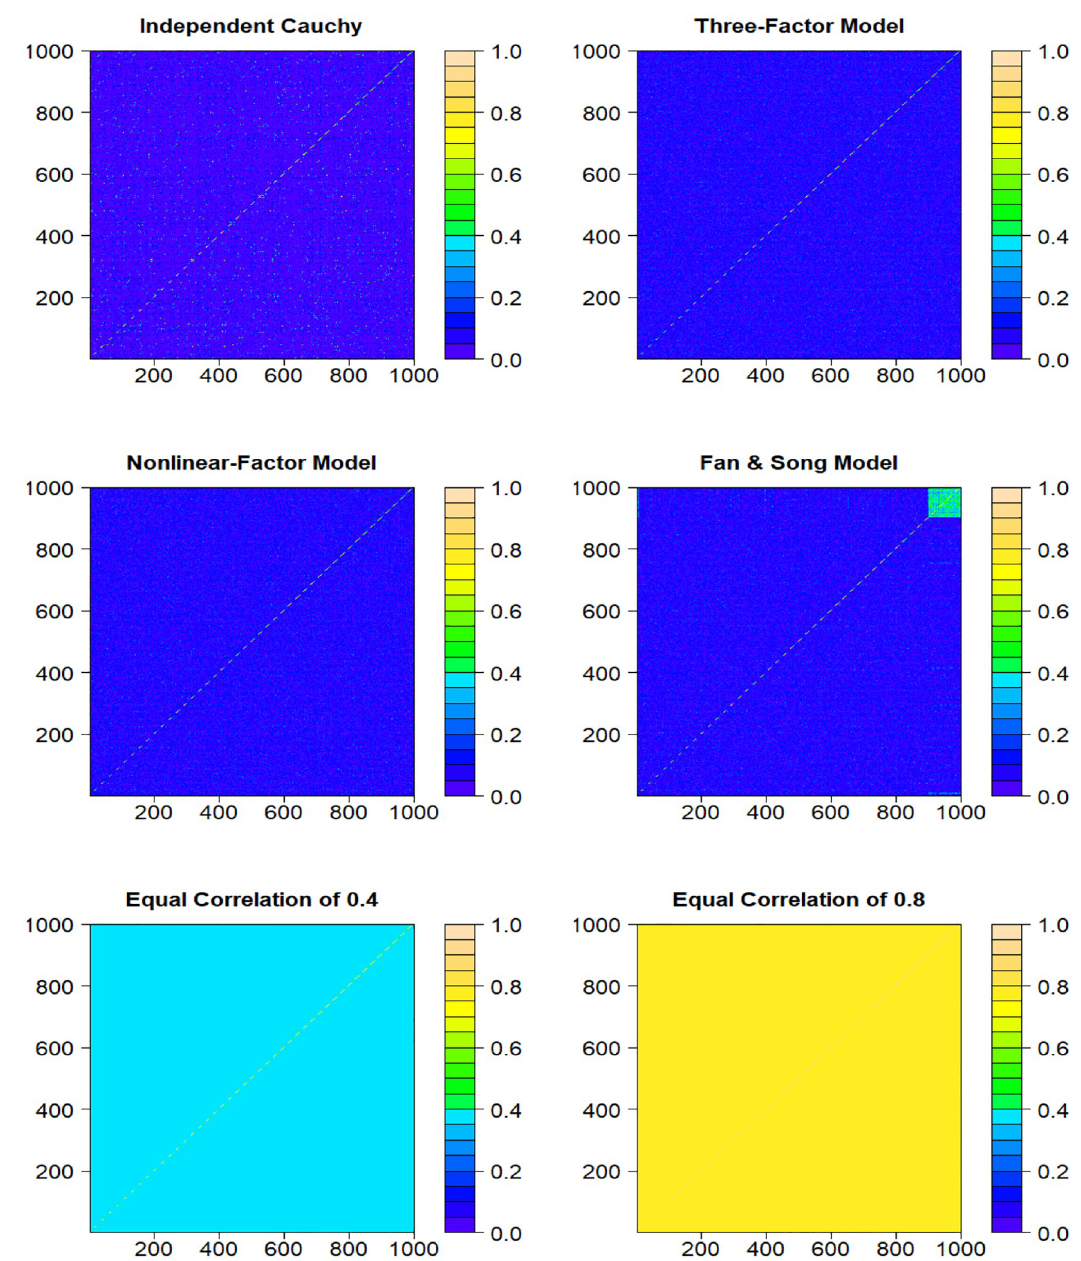
Fig 1. Heatmaps for six covariance structures of error terms Z